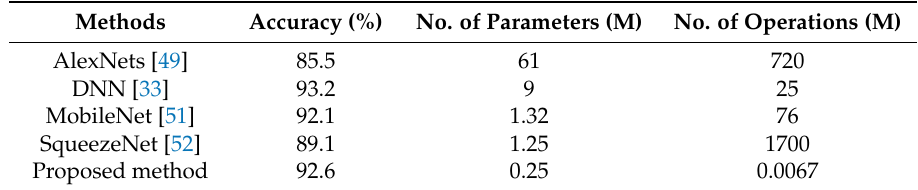
Table 2. Comparison of the number of parameters and operations for the proposed method and a deep neural network-based approach using the CK+